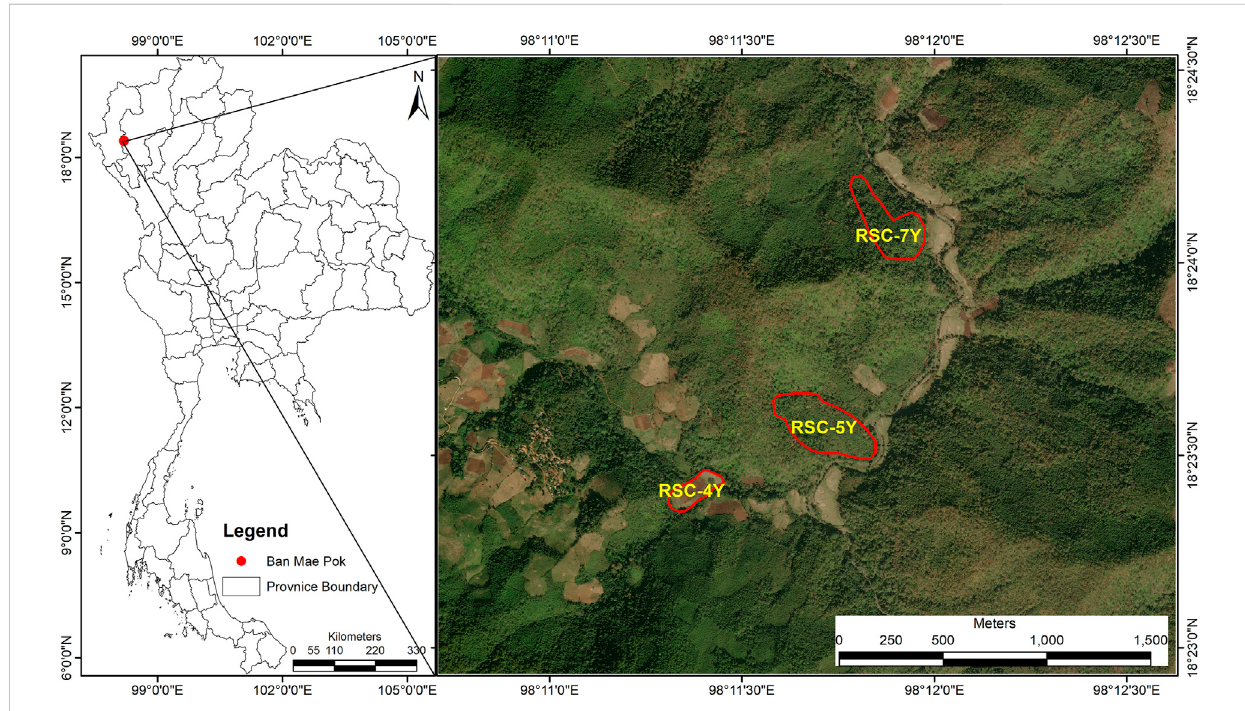
FIGURE 1 Study area; RSC-7Y = 7-year fallow (18 ° 24 ’ 6.57"N, 98 ° 11 ’ 53.68"E), RSC-5Y = 5-year fallow (18 ° 23 ’ 33.38"N, 98 ° 11 ’ 45.99"E), and RSC-4Y = 4-year fallow (18 ° 23 ’ 24.99" N, 98 ° 11 ’ 22.73" E); the aerial image was taken from Google Maps on 2 December